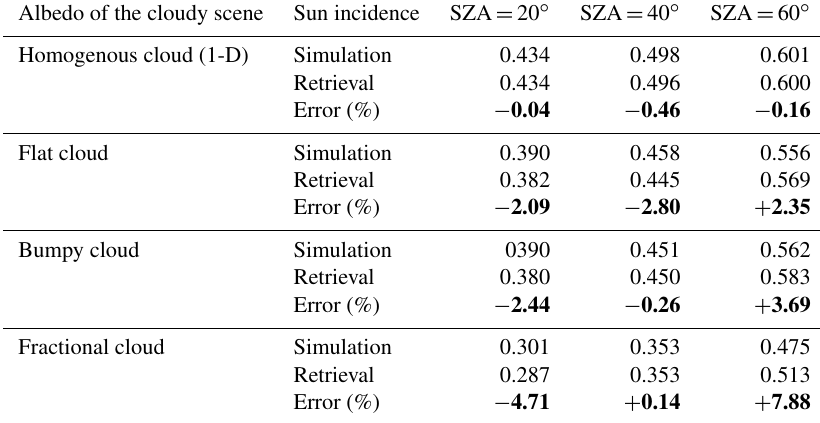
Table 1. For each cloud case, albedo of the cloudy scene obtained from simulation with 3DMCPOL (first line), retrieved with the POLDER operational algorithm (second line) and relative differences [(Retrieval − simulation) / Simulation × 100] between the two values (third line, in bold) for the homogeneous cloud (for control) and for the flat, bumpy and fractional clouds for three solar zenith angles (20, 40 and 60 ◦ ). The mean optical thickness of each cloud is 10 and the effective radius is fixed to